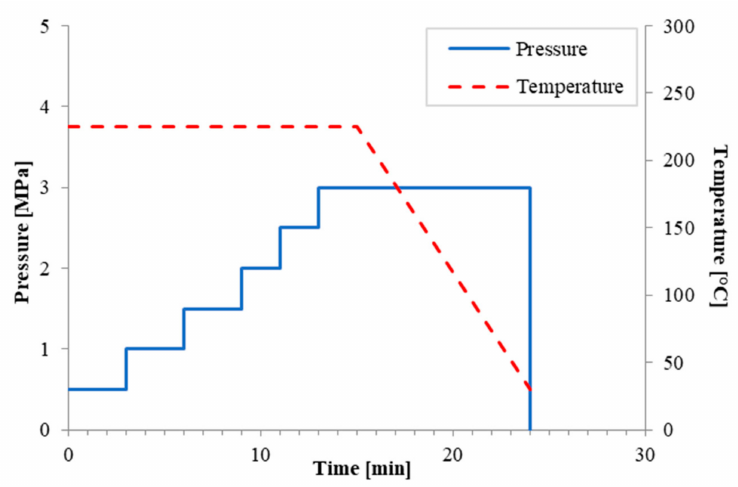
Figure 1. Processing conditions to prepare all PA11 based